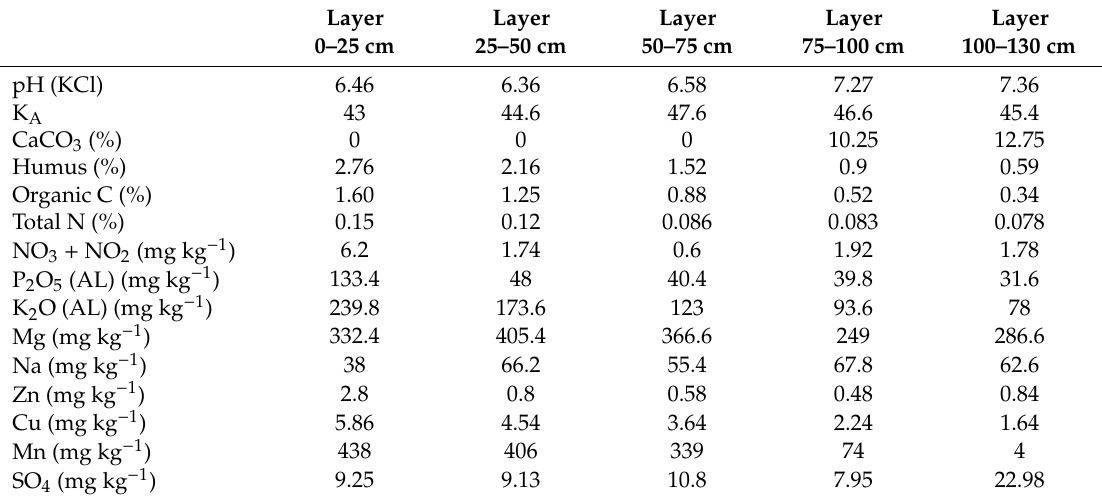
Table 1. Soil analysis results of the experiment area (2015, Debrecen).